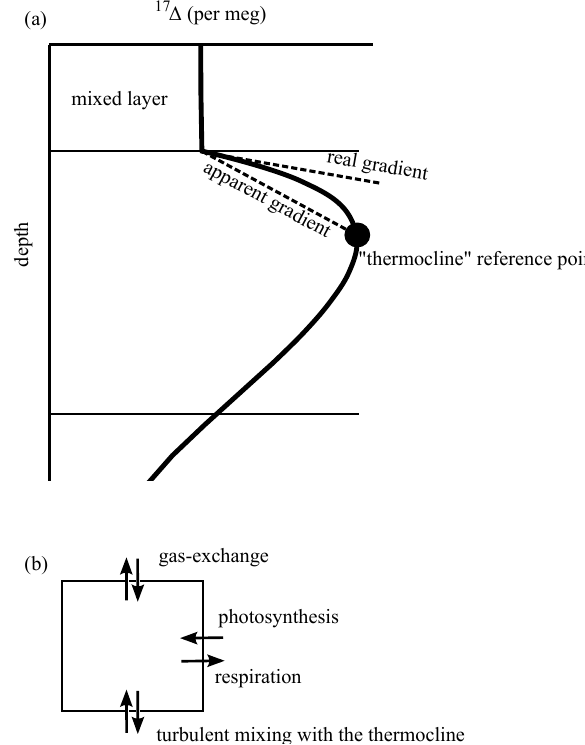
Fig. 1. (a) A schematic illustration of a typical mid-ocean 17 1 ver- tical profile. The dashed lines, which extend below the mixed-layer base define the 17 1 gradient, which in turn, is correlated with the 17 1 “flux” into the mixed layer. Depending on the profile shape, the choice of a “thermocline“ reference point at some depth below the mixed-layer depth, results in a 17 1 gradient which is different than the real 17 1 gradient. (b) A conceptual model of the O 2 iso- topologues fluxes in and out of the